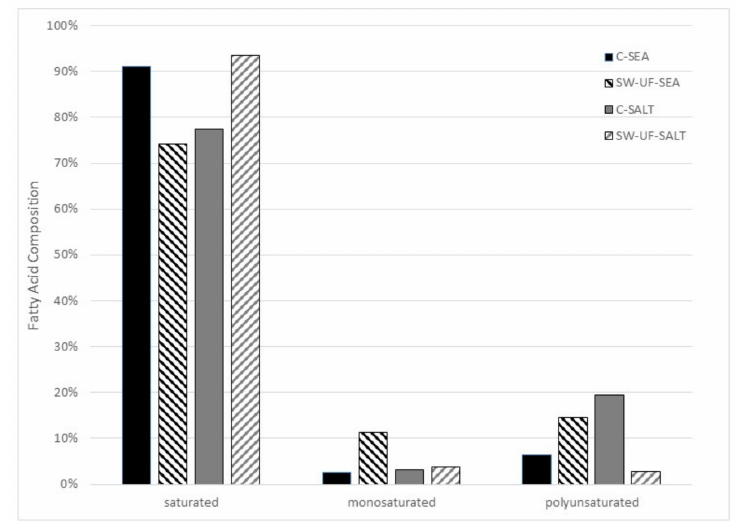
Figure 3. Saturated and unsaturated fatty acid compositions of P. cruentum grown in control and treated swine wastewater media. N = 2 for C-SEA and SW-UF-SEA, N = 1 for C-SALT and